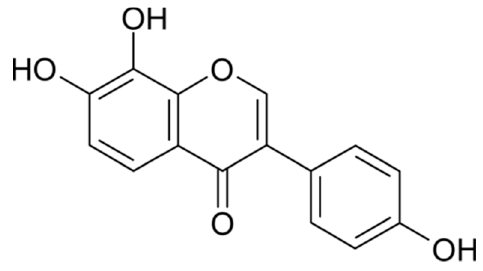
Figure 1. Structure of 8-hydroxydaidzein (8-HD).